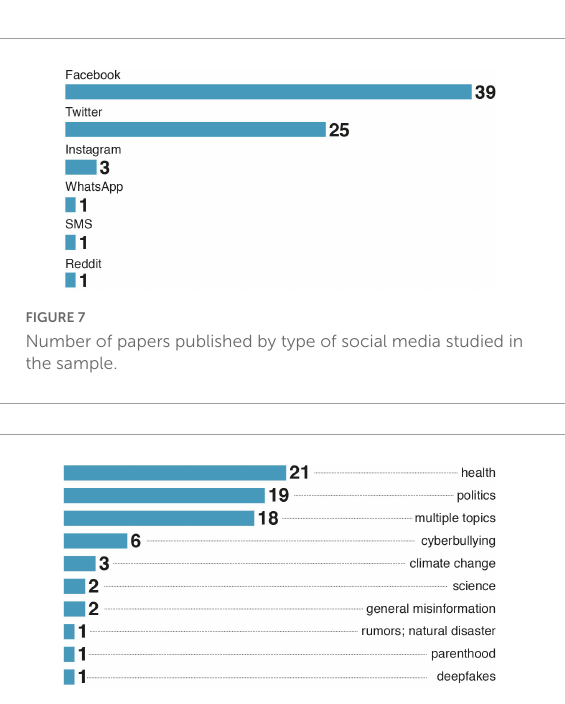
FIGURE8 Number of publications by misinformation types in the